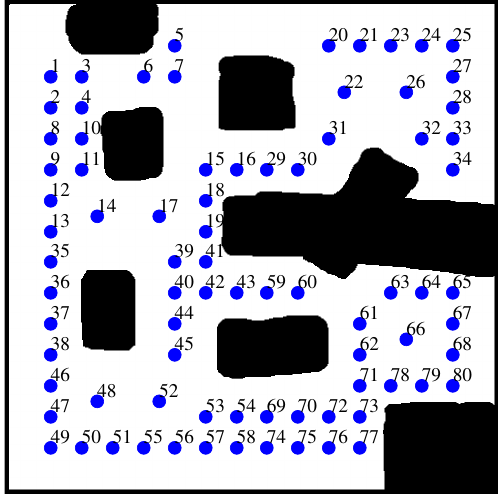
Figure 5. The environment and 80 starting